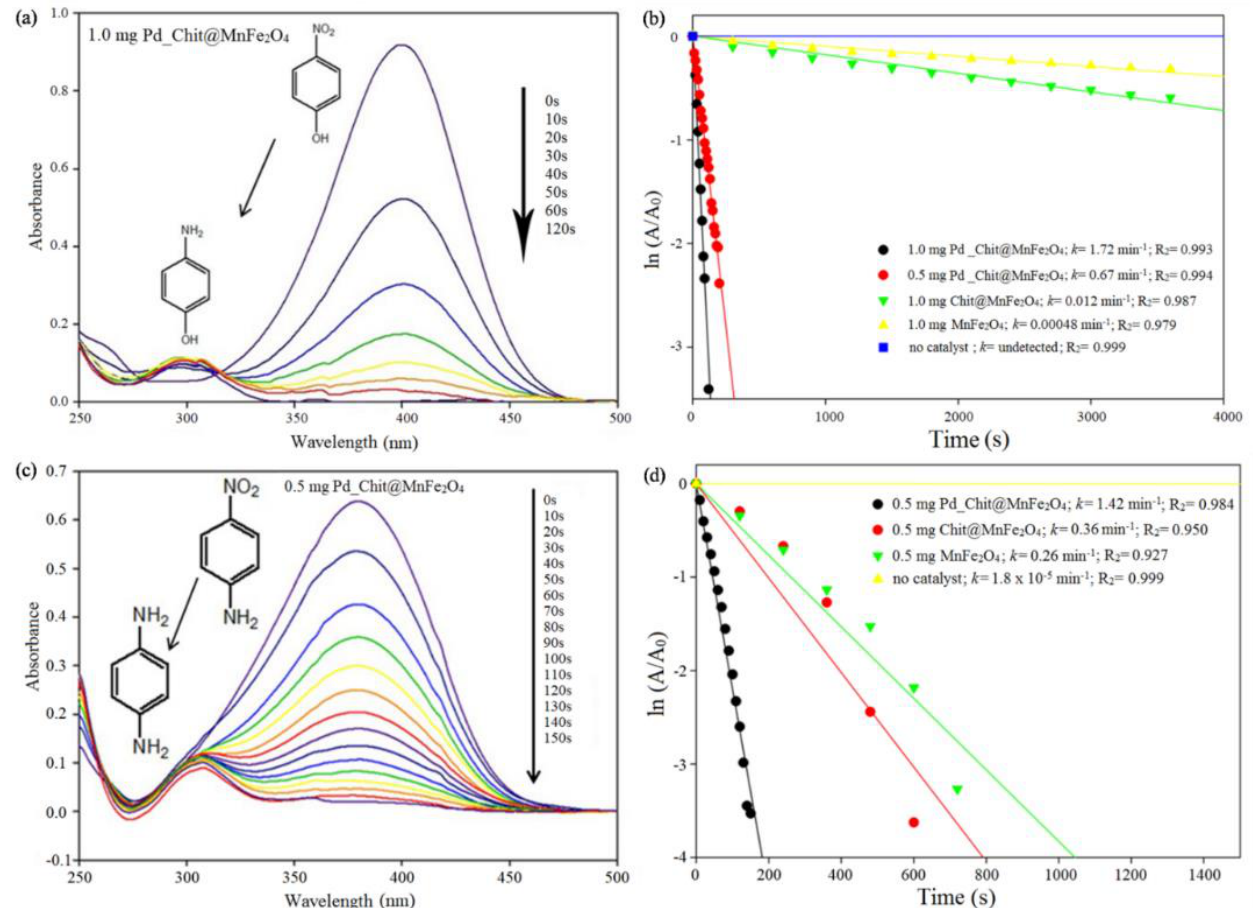
Figure 4. 4 −NP reduction’s ( a ) UV − Vis spectra with 1.0 mg Pd − Chit@MnFe 2 O 4 and ( b ) pseudo-first- Figure 4. 4-NP reduction’s ( a ) UV-Vis spectra with 1.0 mg Pd-Chit@MnFe 2 O 4 and ( b ) pseudo-first- order kinetic plot ( c ) UV − Vis spectra with 0.5 mg Pd − Chit@MnFe 2 O 4 and ( d ) pseudo-first-order ki- order kinetic plot ( c ) UV-Vis spectra with 0.5 mg Pd-Chit@MnFe 2 O 4 and ( d ) pseudo-first-order kinetic netic plot.